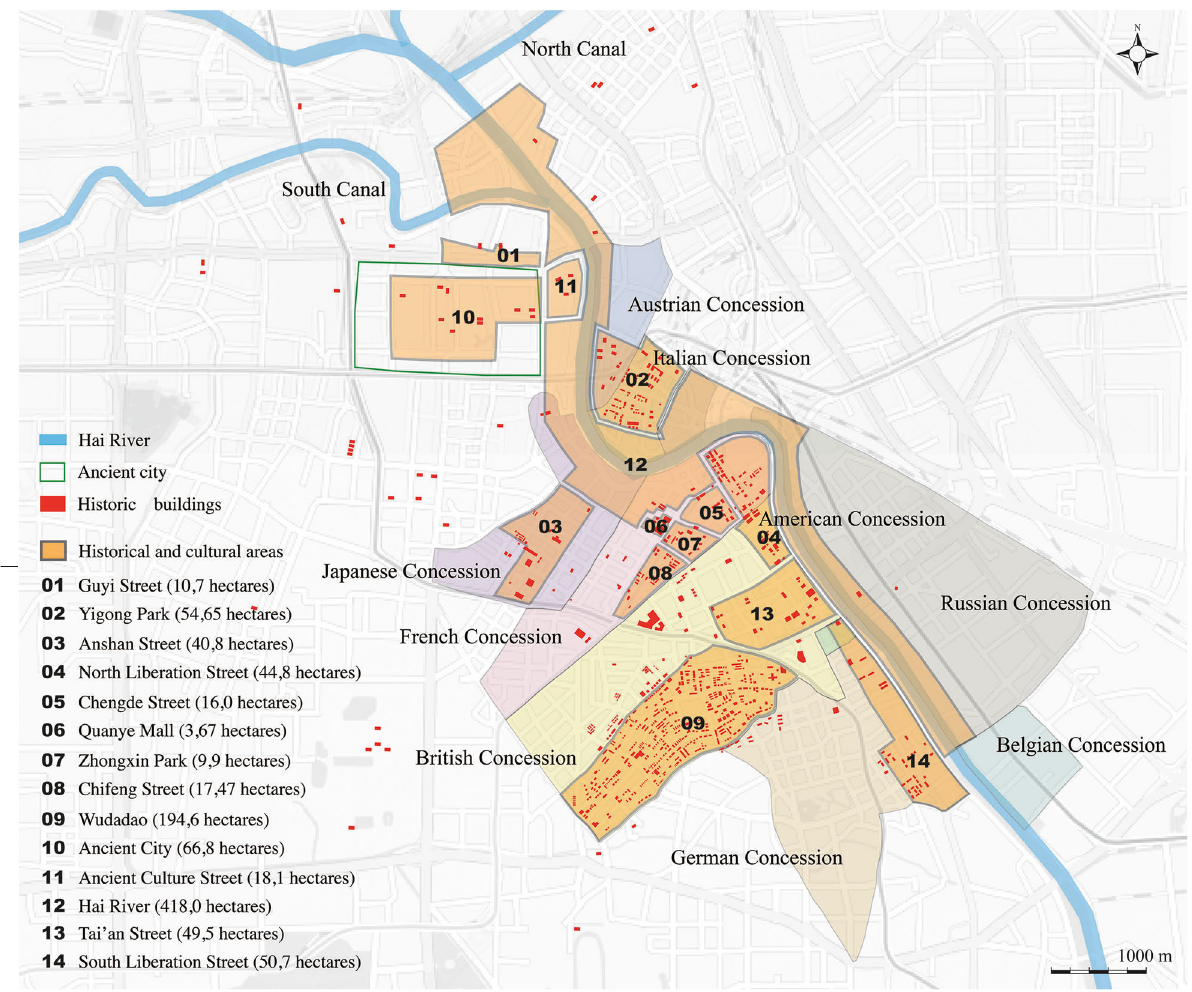
Fig. 6 ‘ Historical and cultural areas ’ and historic buildings in Tianjin in 2011 (Source: Yue Lu,